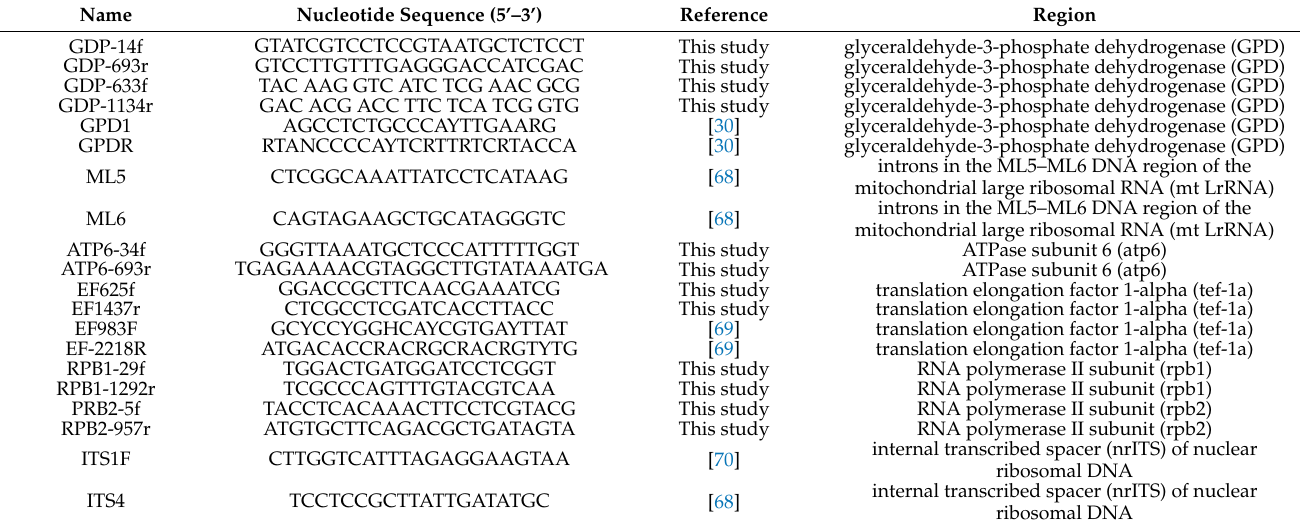
Table 2. Primers used for PCR fingerprinting, DNA sequence amplification and